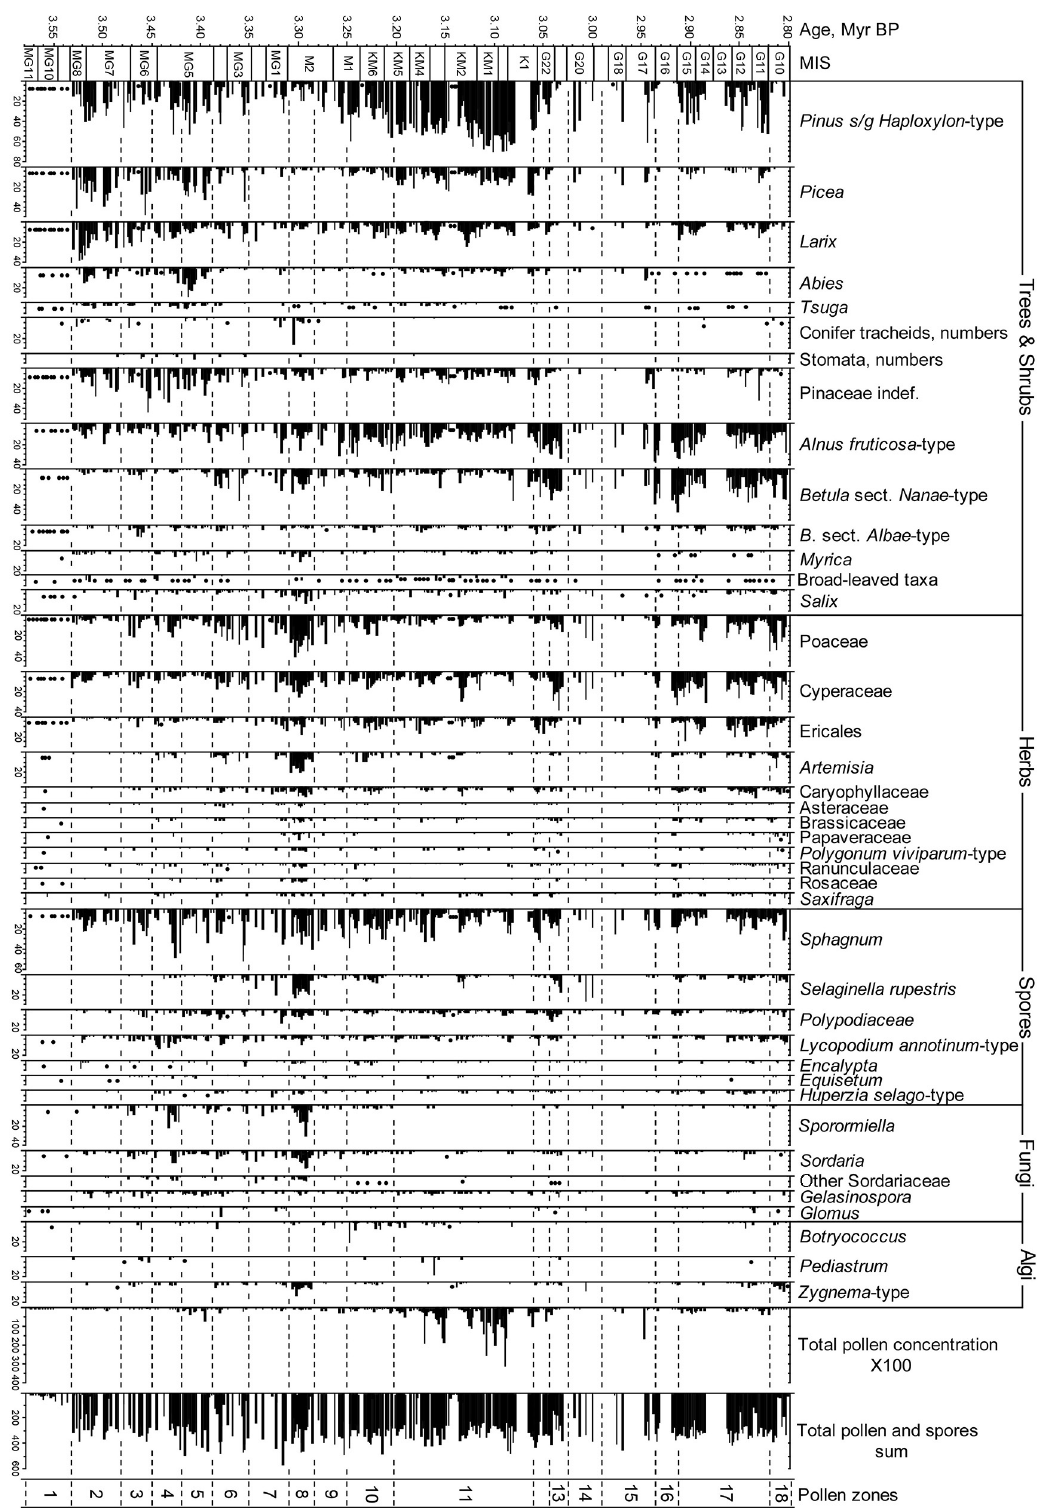
Figure 3a. Percentage pollen, spore, and non-pollen-palynomorph diagram. The most common pollen and spores types between ca. 3.58 and 2.8Myr